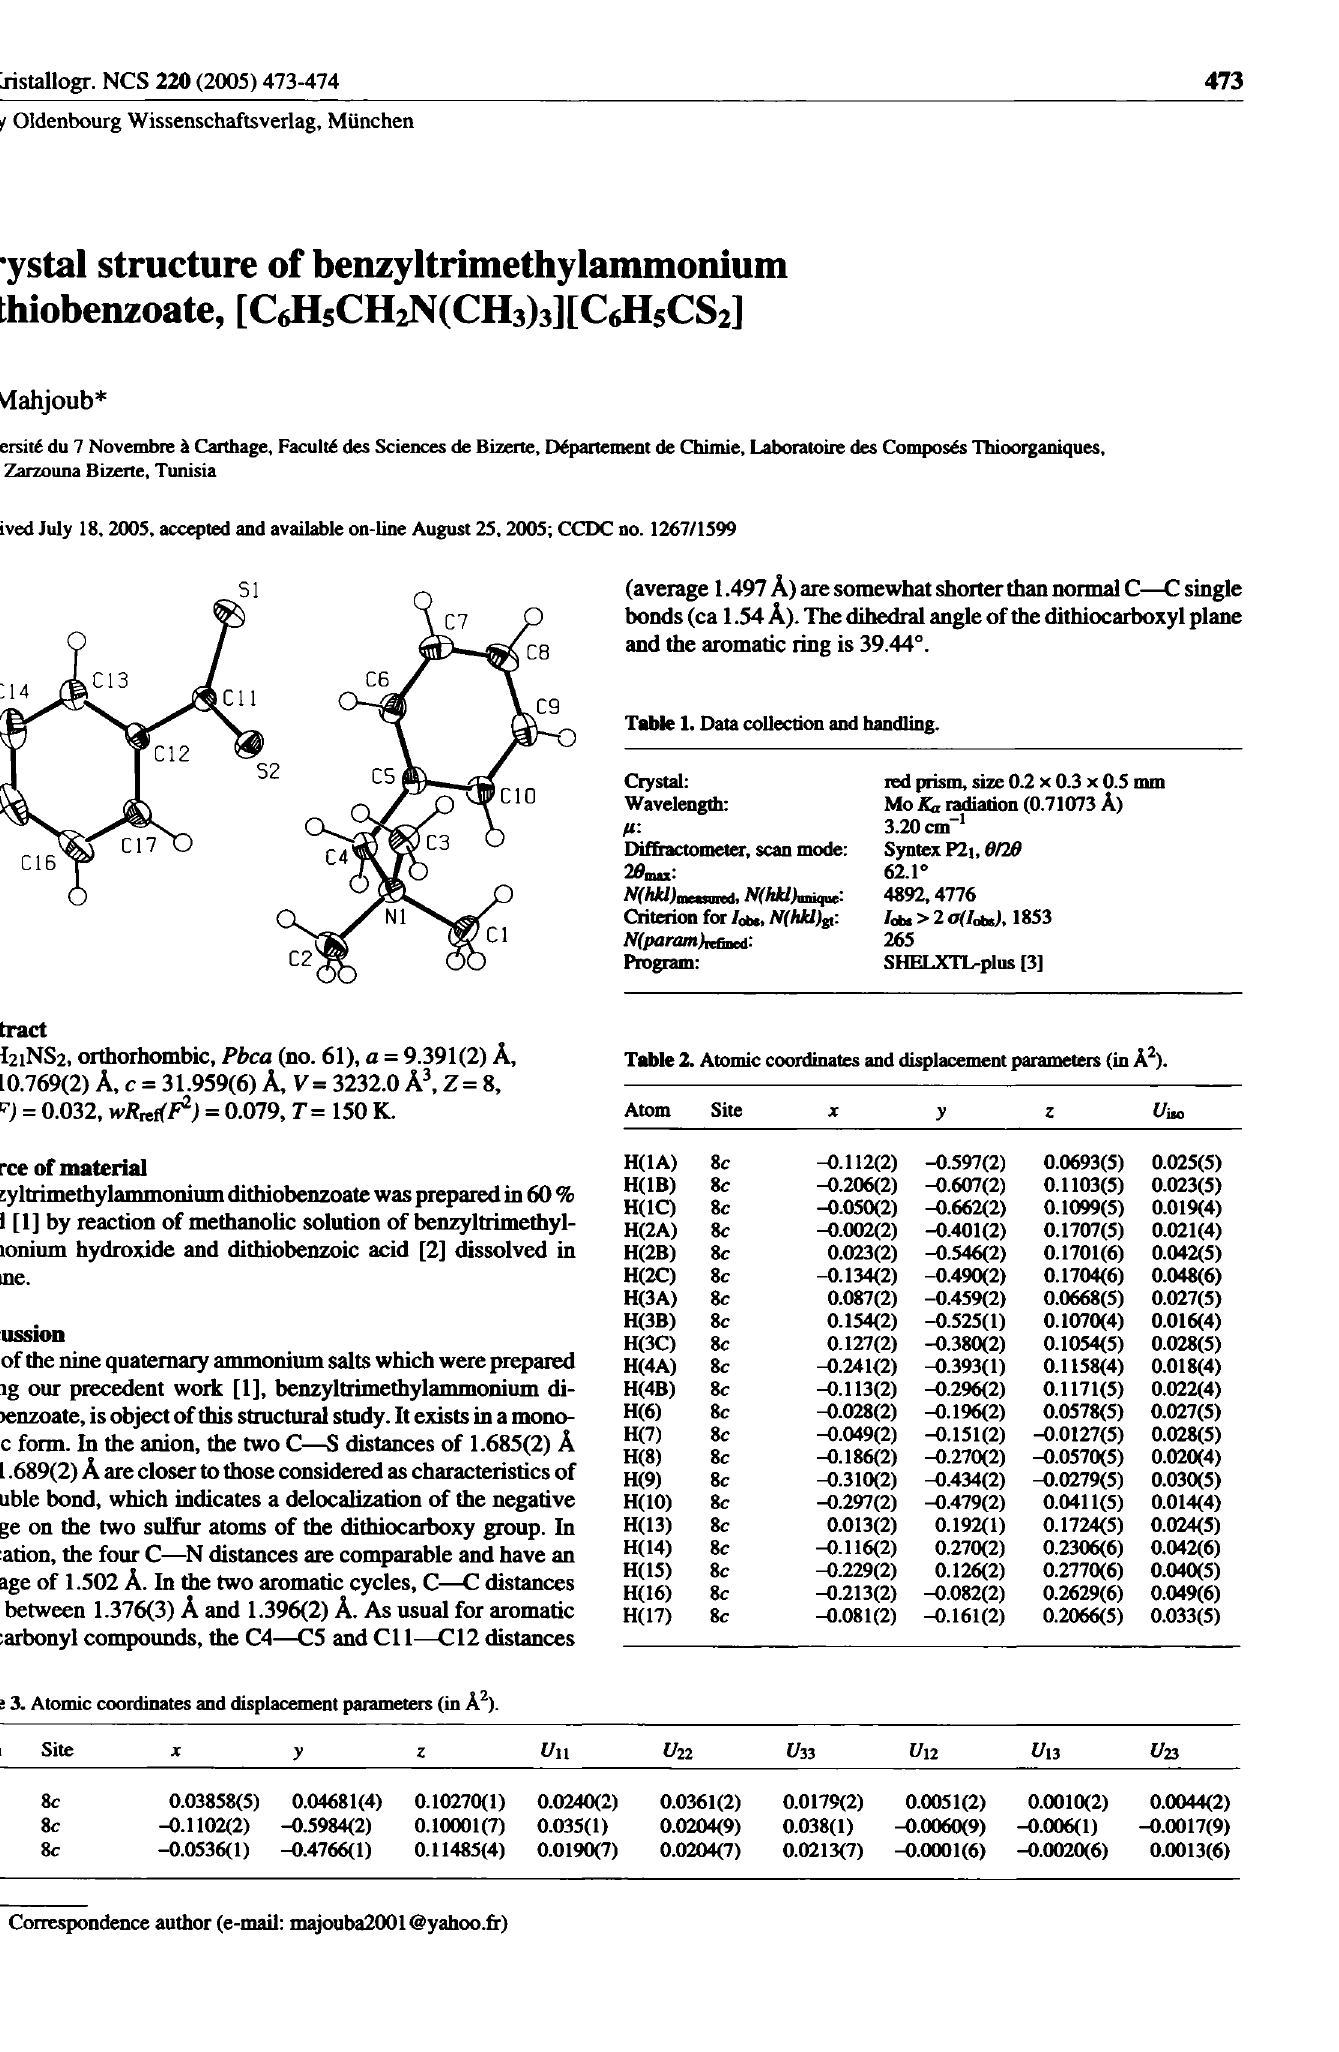
Table 3. Atomic coordinates and displacement parameters (in A 2